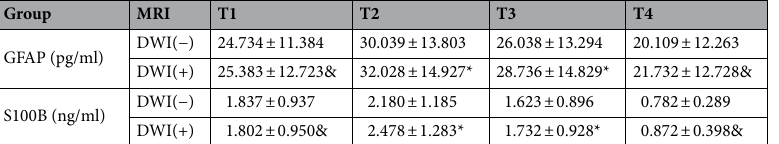
Table 3. Serum concentrations of GFAP and S100B in patients with negative/positive DWI after CAS. The GFAP and S100B in the serum of patients with positive DWI showed higher concentrations than patients with negative DWI at T2 and T3 (*P < 0.05). However, there was no difference in GFAP and S100B at T4 in patients with negative and positive DWI after CAS ( & P > 0.05). DWI diffusion-weighted imaging, CAS carotid artery